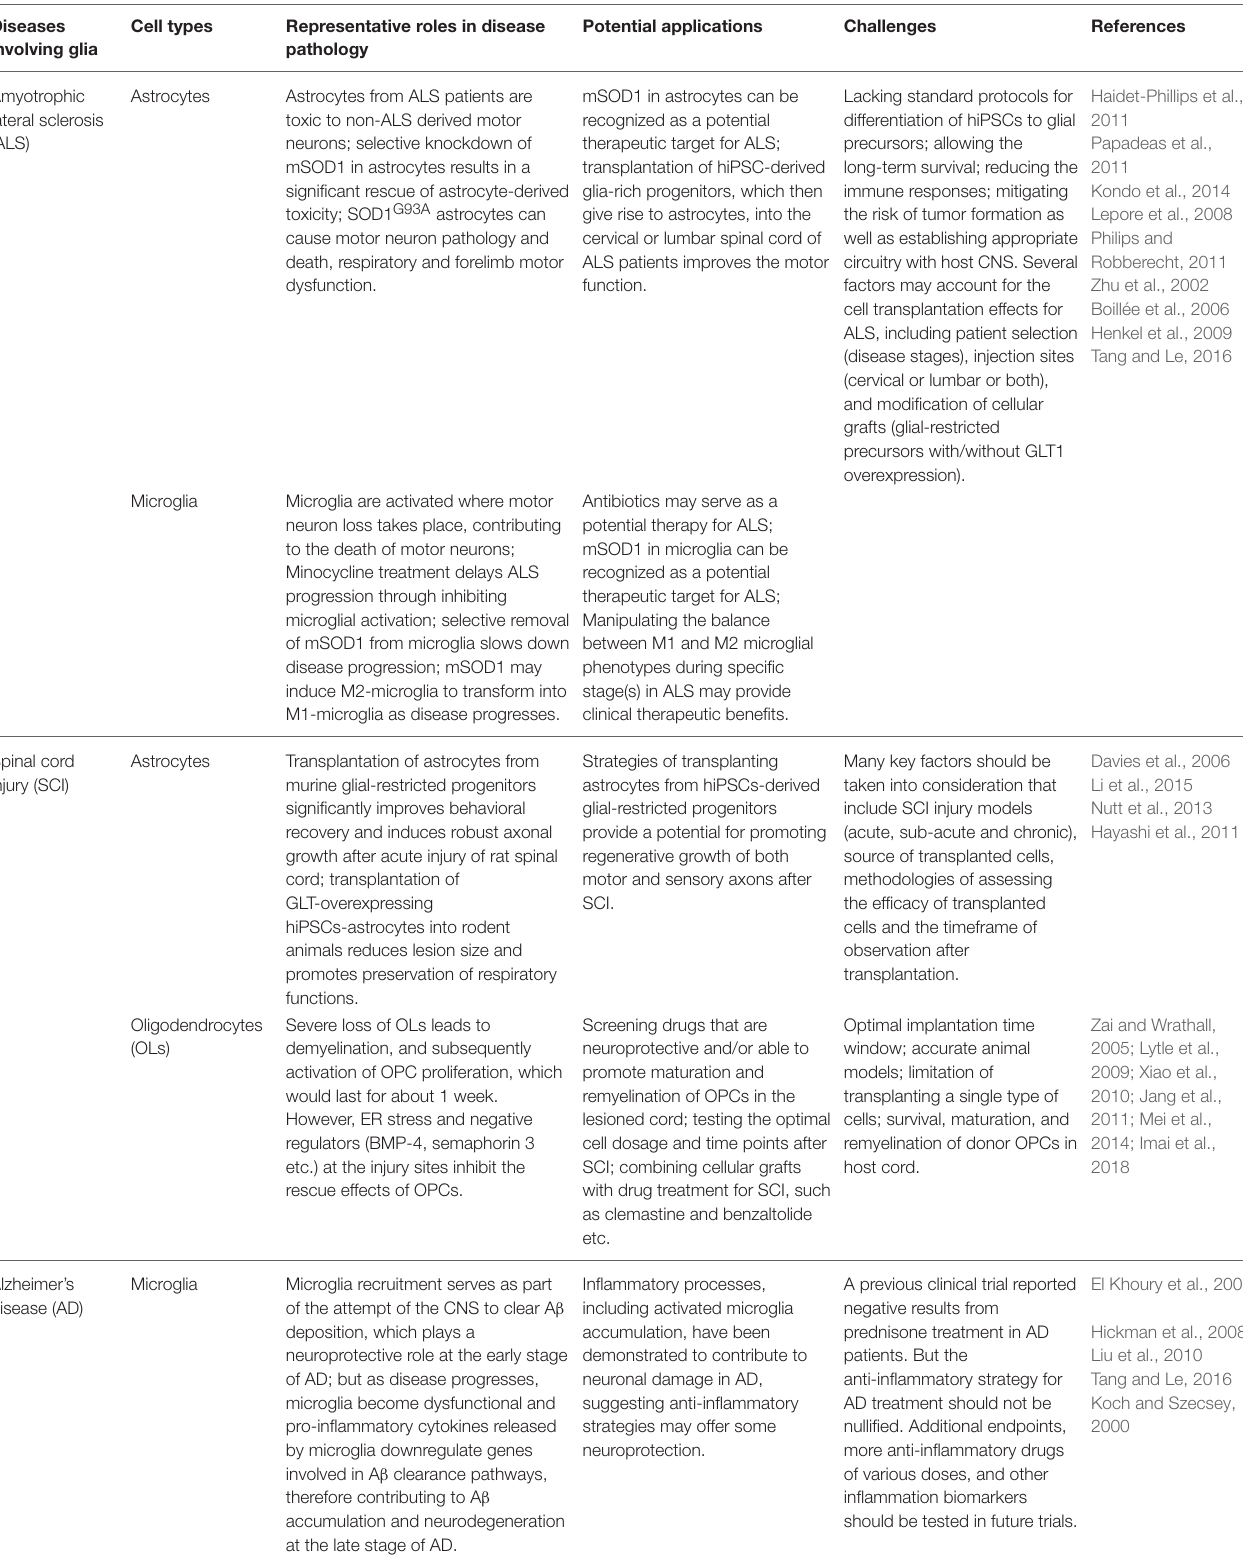
TABLE 2 | Potential application of hiPSC-derived glial cells in neurodegenerative diseases and cell replacement